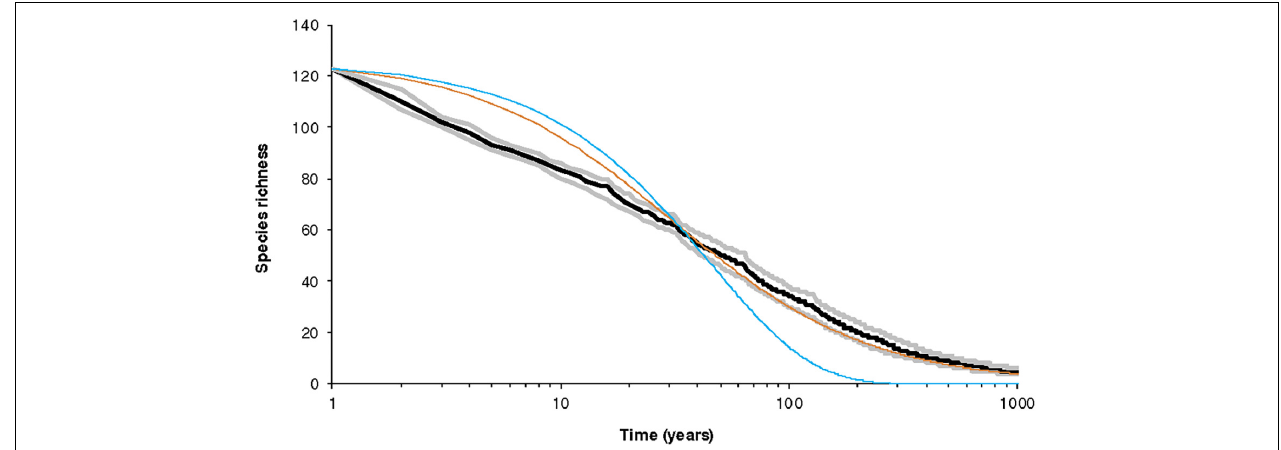
FIGURE 6 | Pattern of survival as a function of time after habitat is reduced suddenly (at t = 0). The area initially has 123 species in broken-stick configuration with each species having a large population. The reduction in area is such that the reduced total number of individuals is 13,000 so the average population falls to just above 100. The model has K = 8 with B = 1.5 and the minimum viable population is set at M = 2. This figure summarizes 1,000 simulations. The curves correspond to the five quartiles of species richness at each year. Notice that decay occurs approximately linearly on a logarithmic scale. The black line is the median and the gray lines the hinges (25th and 75th percentiles). The other curves are the equivalent exponential decay (blue) and hyperbolic decay (brown, for neutral theory) with the same S 0 and the same t 50 . The dynamics are according to Equations (11)–(13) and thus includes extinction. However, colonization is assumed to be zero.